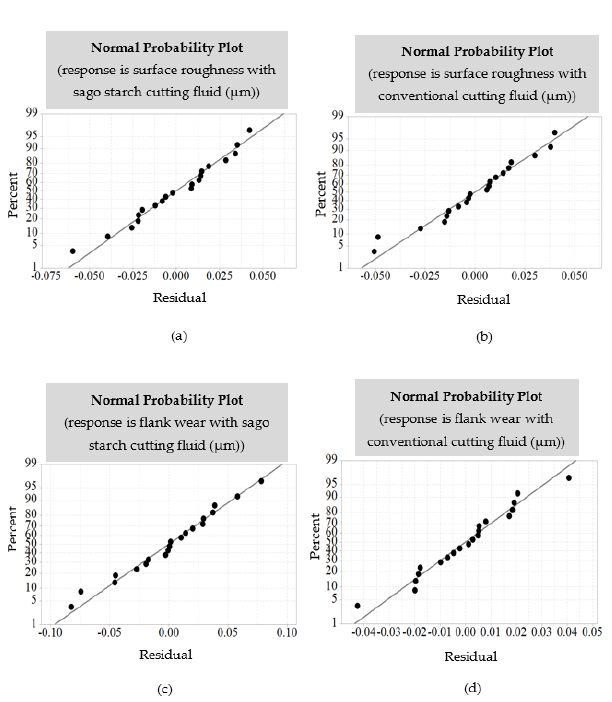
Figure 4. Normal probability plot of the residuals corresponding to surface roughness ( a ) with water ‐ soluble sago starch cutting fluid, ( b ) with conventional cutting fluid, and flank wear ( c ) with water ‐ soluble sago starch cutting fluid, and ( d ) with conventional cutting fluid.